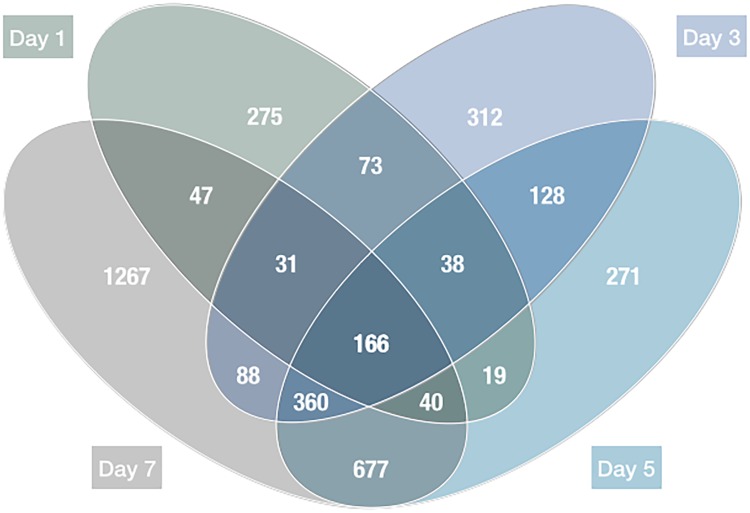
Venn diagram of significantly differentially expressed transcripts over the time course of REV infection.The image displays the number and overlap of differentially expressed transcripts in response to in vitro REV infection at 1, 3, 5, and 7 days post-infection. The numbers of transcripts differentially expressed at more than one time point are shown in the overlapping regions. Additionally, the intersection of the four circles indicates transcripts that were up- or down-regulated at all time points of REV infection.